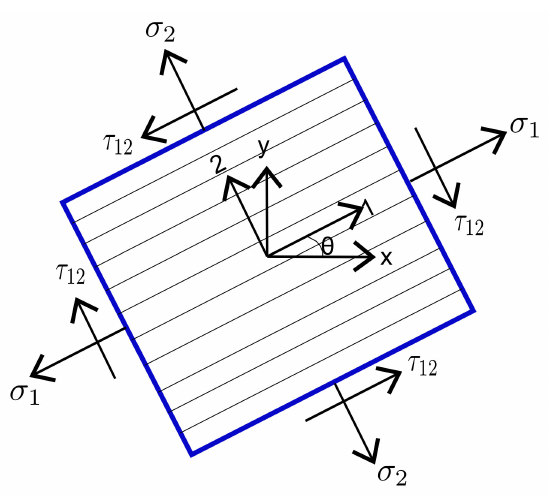
Figure A2. Fiber orientation. The total thickness and side length of the plate are chosen to be 2.25 mm and 150 mm, respectively, where all layers have the same thickness. A total of 12 stacking sequences with fiber orientation angles of 0 ◦ , 45 ◦ , 60 ◦ and 90 ◦ have been analyzed. Figure A3 shows the correlation between the analytical results and the finite element solutions. A coefficient of determination of R 2 = 0.96 could be observed.